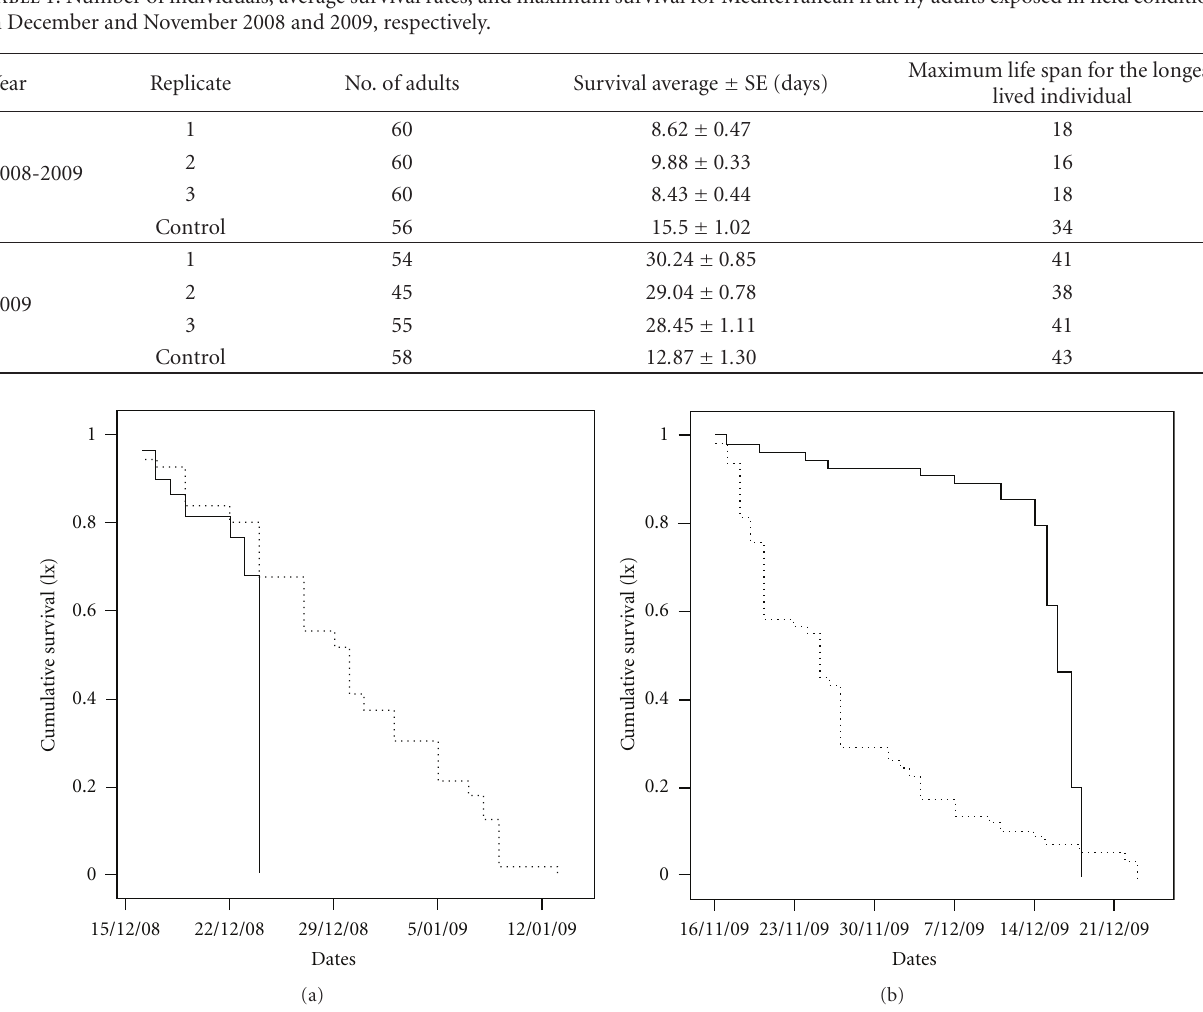
Figure 1: Cumulative survival rates of adult medflies exposed to field conditions on (a) December 16, 2008, and (b) November 16, 2009, and respective controls maintained at 25 ◦ C in laboratory conditions (dotted line, control; solid line, average for three